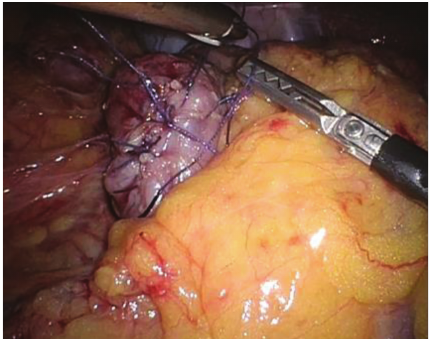
Figure 4: Laparoscopic view after the closure of the duodenal wall defect. The closure of the defect in the duodenal wall was performed by the laparoscopic hand-suturing